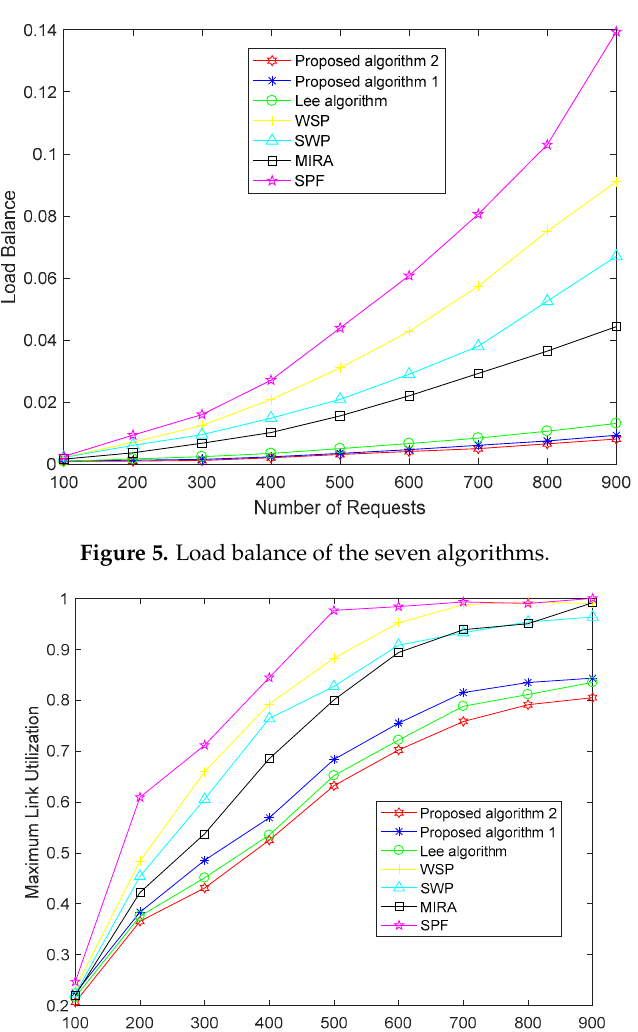
Figure 5. Load balance of the seven algorithms.